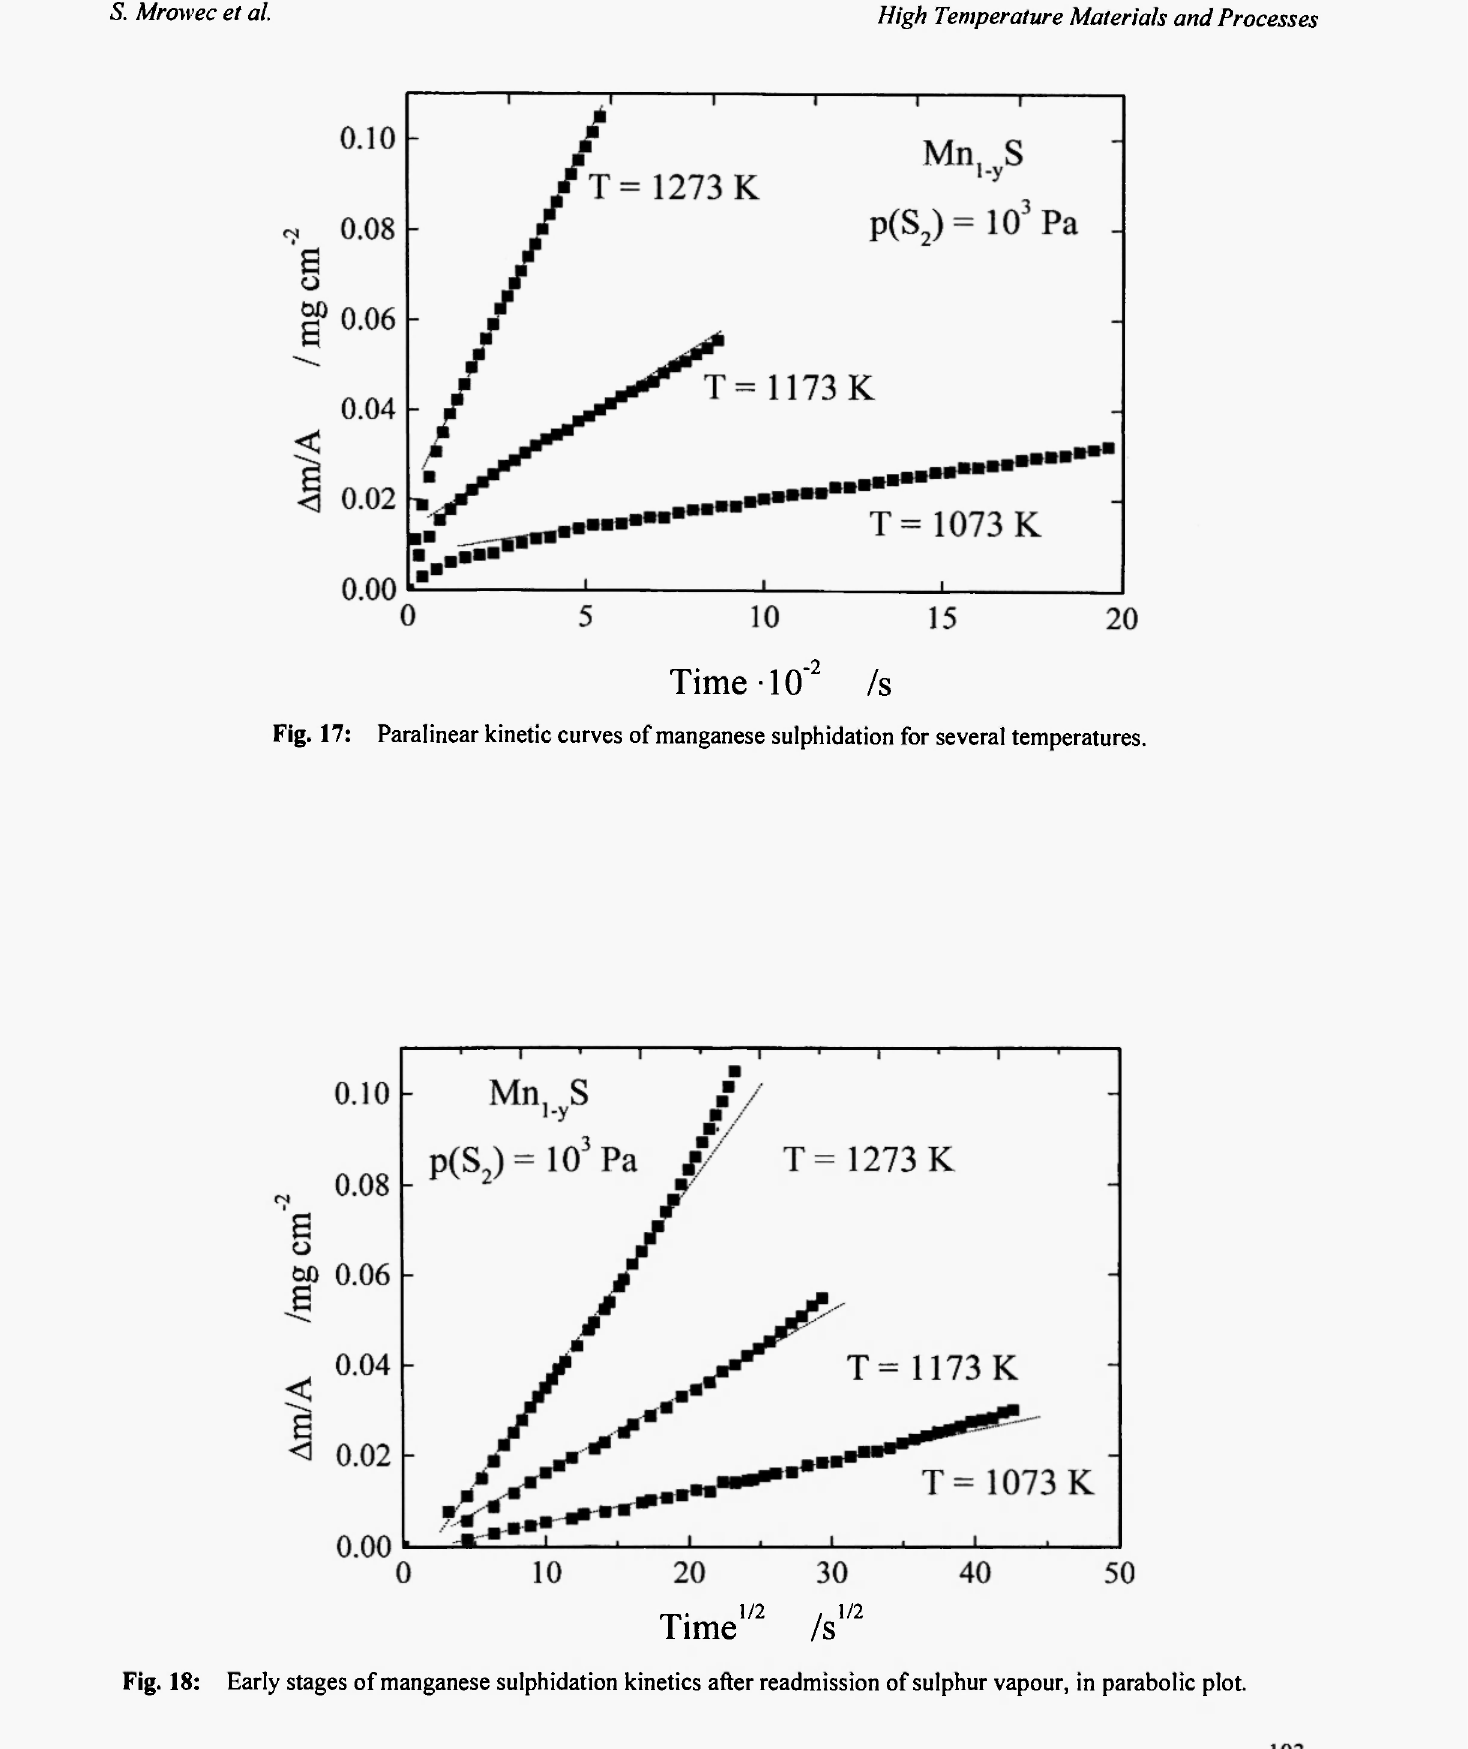
Fig. 18: Early stages of manganese sulphidation kinetics after readmission of sulphur vapour, in parabolic